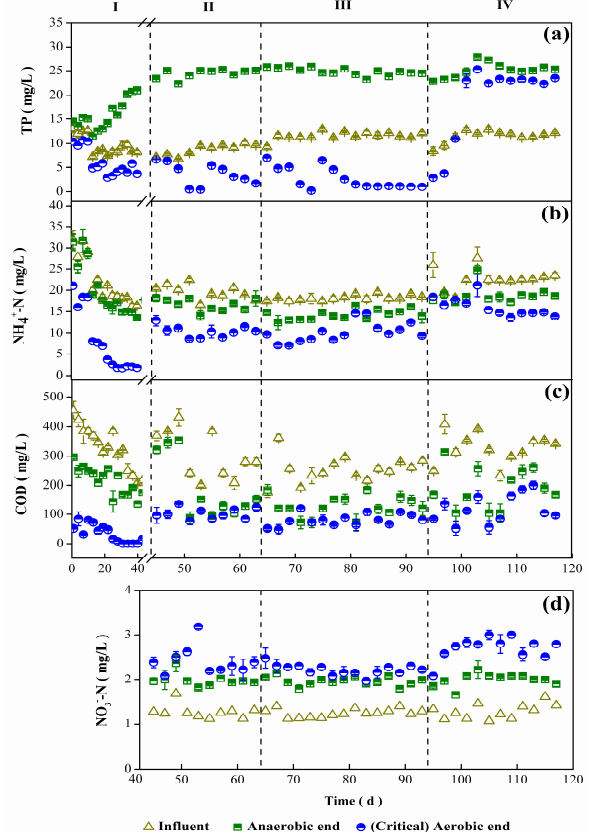
Figure 2. The overall performance of anaerobic–critical aerobic (A–CA) SBR: ( a ) total phosphorus (TP) removal performance during the four stages; ( b ) NH 4 + –N removal performance during the four stages; ( c ) COD removal performance during the four stages; ( d ) NO 3 − –N removal performance during the four stages. Error bars indicate the standard deviations of the measurements.